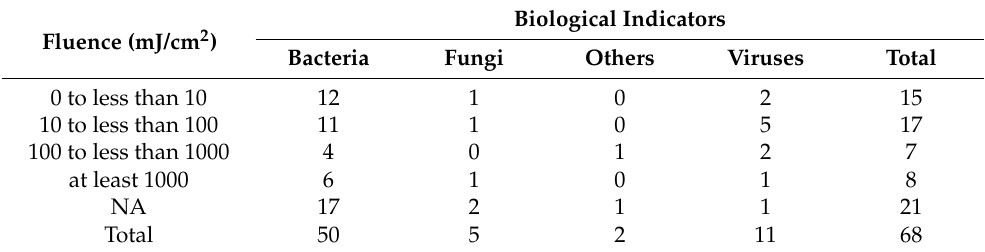
Table 4. Fluencies according to the decontaminated biological indicators.